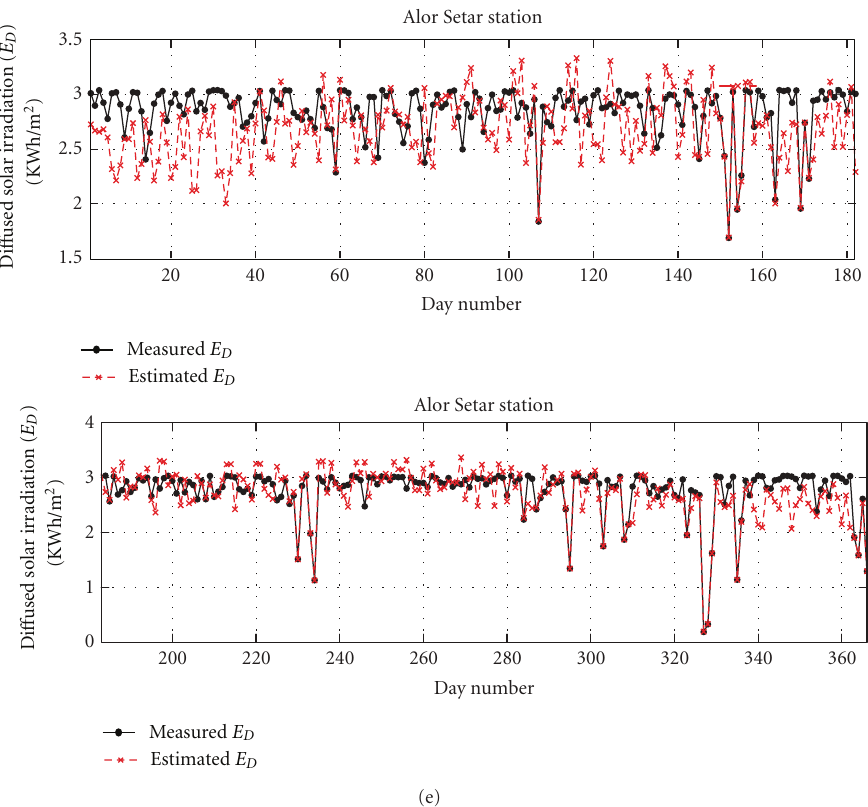
Figure 7: Comparison between the measured and predicted di ff used solar irradiation.